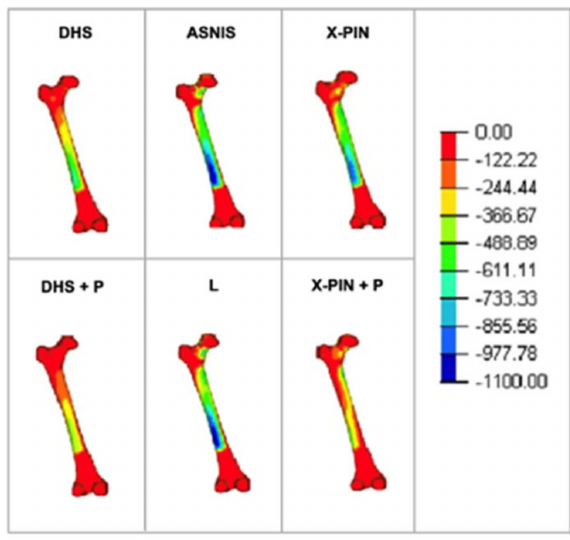
Figure 7. Minimum principal tension in the models. The Max P1 values were 29, 24, 23, 19, 28, and 25 MPa (Figure 8A). The models were balanced except for the L model, which had a lower value. The Max P2 values were 36, 27, 47, 42, 31, and 21 MPa (Figure 8B), with the X-PIN+P results 55% and 50% lower than ASNIS and L (the multiple cannulated screw models), respectively.